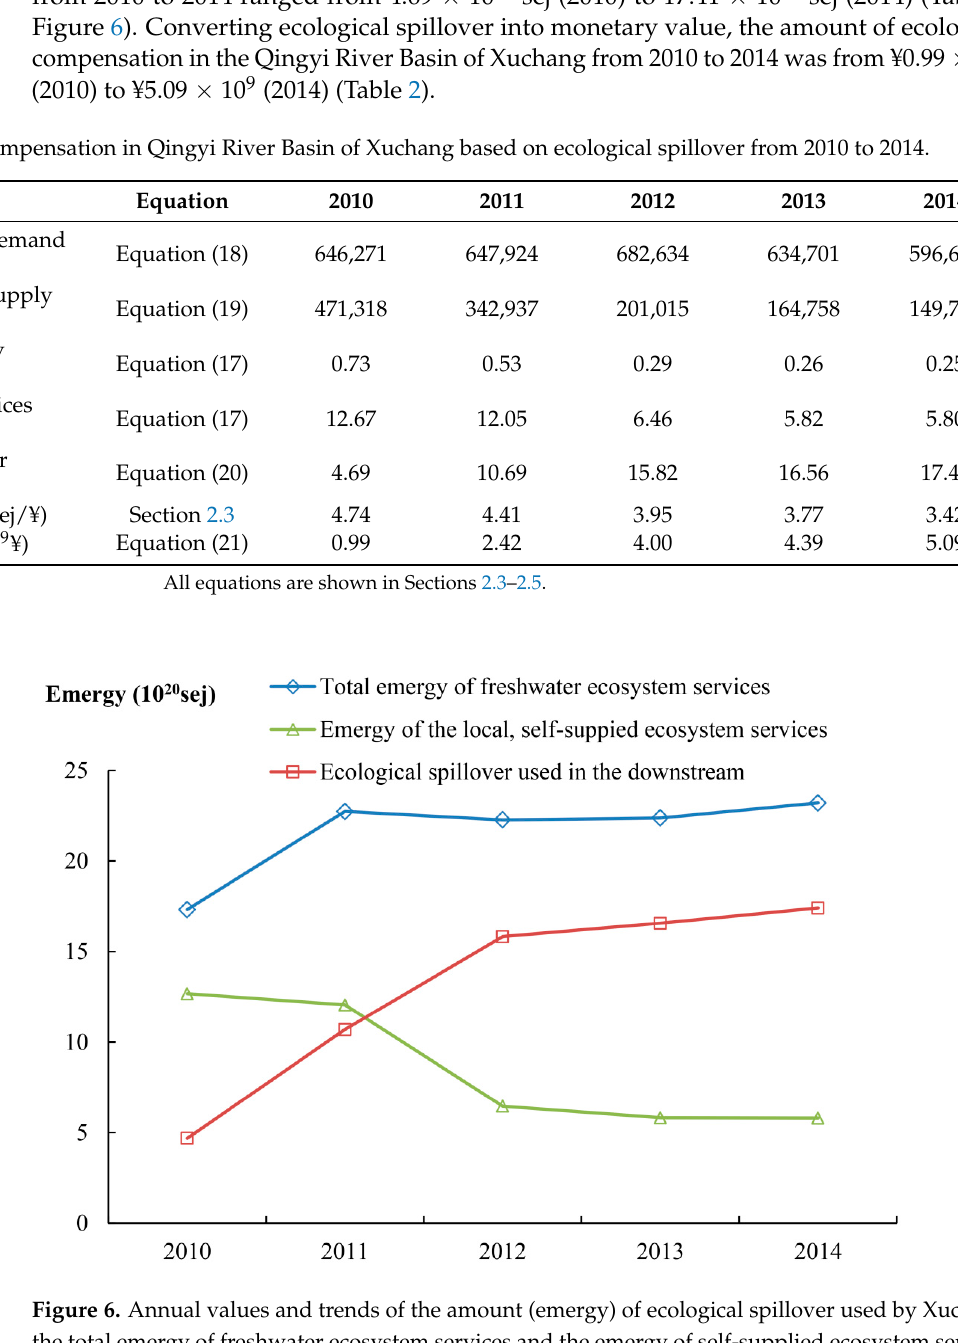
Table 2. Ecological compensation in Qingyi River Basin of Xuchang based on ecological spillover from 2010 to 2014.